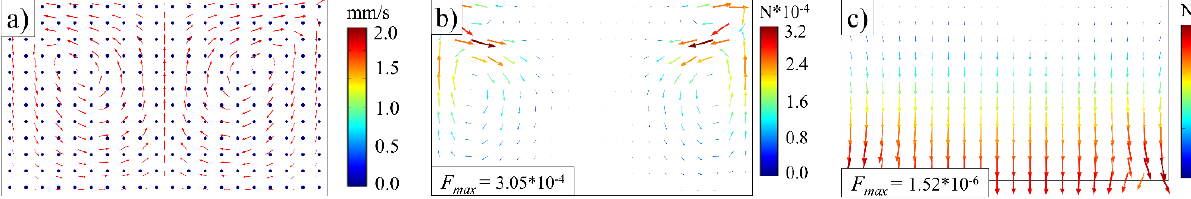
Figure 4. Forces on fluorescent particles (ultrasonic frequency, 20 kHz; ultrasonic amplitude, 80 µ m). ( a ) Seeding the fluorescent particles. ( b ) Stokes drag force distribution. ( c ) Acoustic radiation force